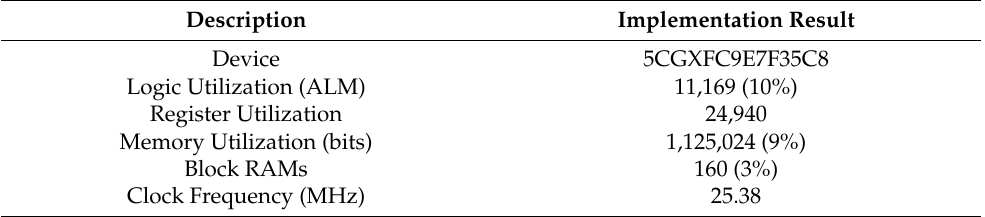
Table 3. Implementation results for the complete feature extraction and template matching system.